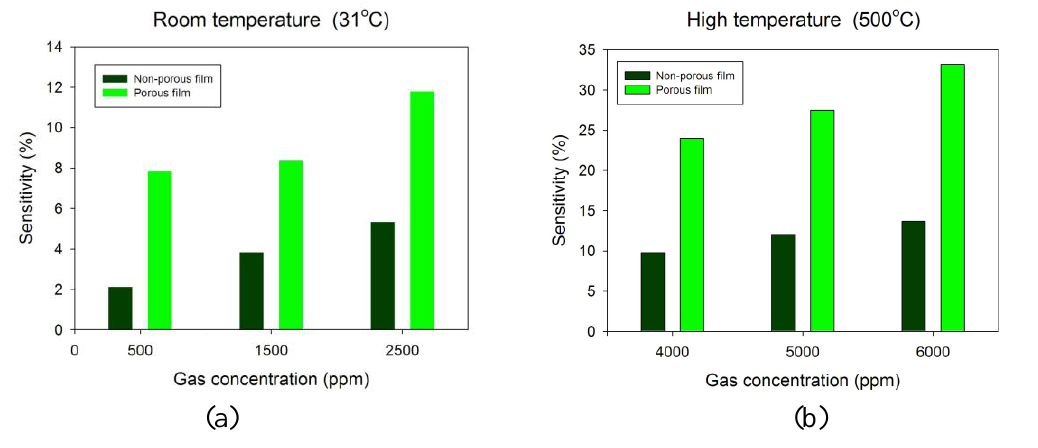
Figure 11. Comparative charts of sensitivity vs. oxygen concentrations with respect to non-porous and porous TiO thin film sensors at (a) room temperature of 31  C and 2 (b) a high temperature of 500 